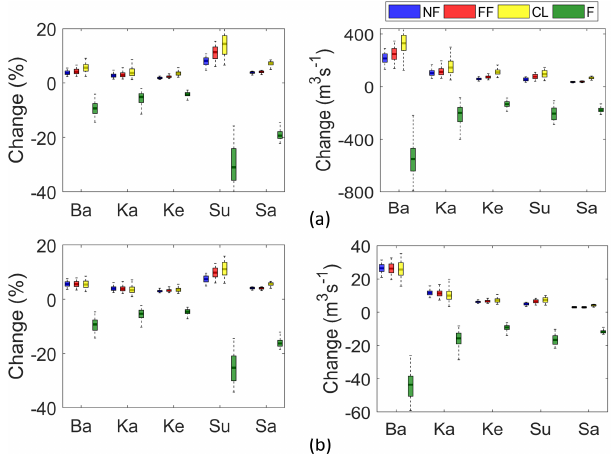
Figure 7. ( a , left) Percent change in extreme flows (i.e., 95th per- centile or higher).( a , right) Change in extreme flows (in m 3 s − 1 ).( b , left) Percent change in mean flows. ( b , right) Change in mean flows (in m 3 s − 1 ), averaged annually over 2001–2010 in the Near Future (NF), Far Future (FF), All Cropland (CL) and All Forest (F) scenar- ios with respect to baseline scenario for all the subcatchments. Note that the daily meteorological forcing used in all the model simula- tions are obtained from the current climatology (i.e., 1990–2010). The results are shown for the behavioural model simulations ob- tained through